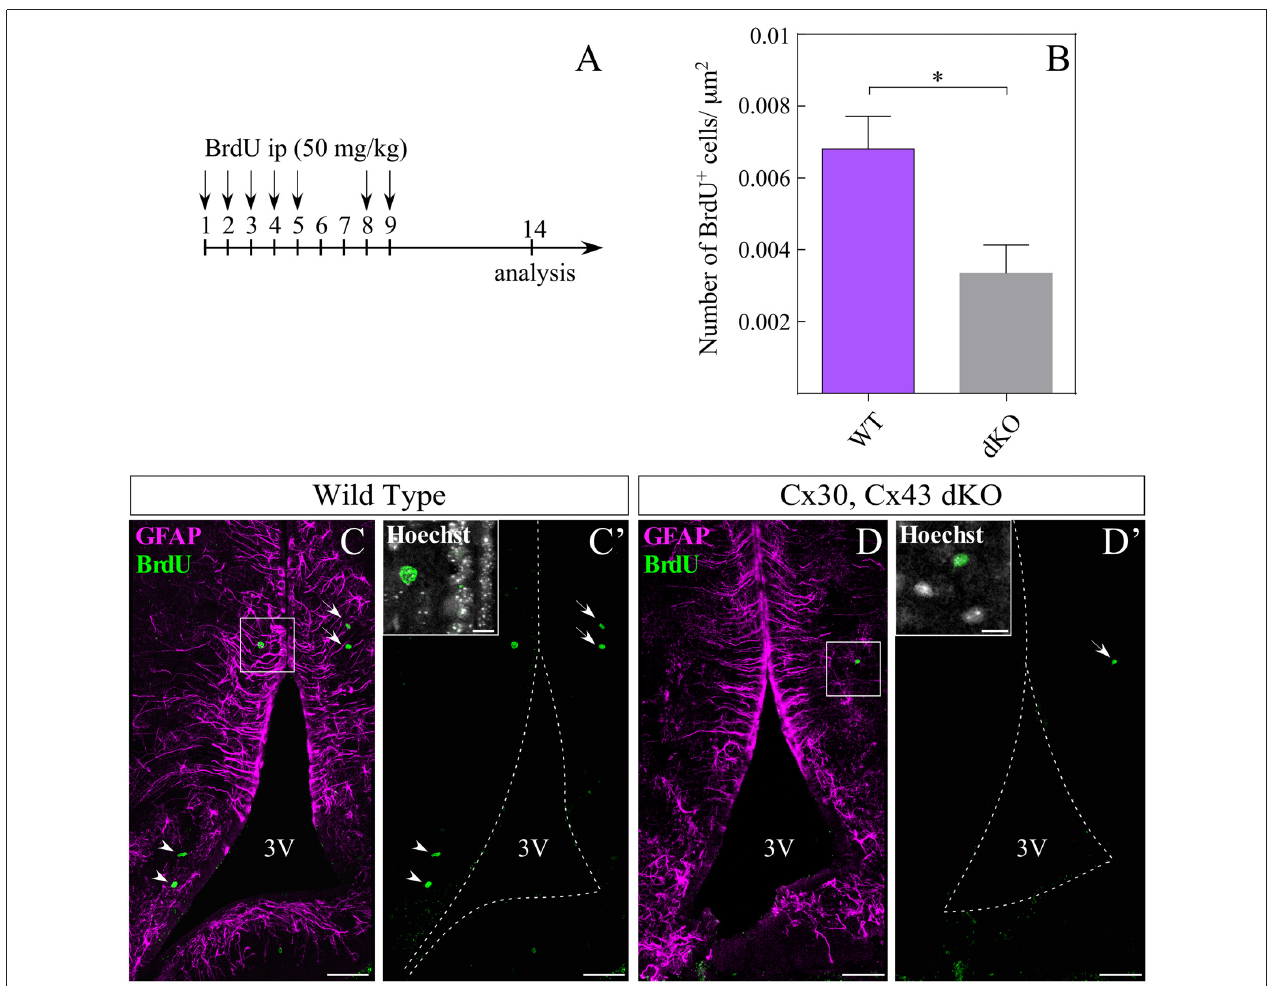
FIGURE 7 | Loss of gap junction coupling affects hypothalamic cell proliferation. Intraperitoneal injection of bromodeoxyuridine (BrdU) was performed as described in (A) . (B) Number of BrdU-positive cells in the parenchyma was quantified in three dKO (13 slices) and four wild type mice (23 slices) and the results were normalized to the area analyzed ( µ m 2 ), using the ROI manager of ImageJ software. Statistical analysis was performed using the non-parametric Mann Whitney one tail test, ∗ P < 0.05. Representative immunohistochemistry using anti-BrdU (green) and anti-GFAP (magenta) antibodies in frontal sections of WT (C,C (cid:48) ) and dKO (D,D (cid:48) ) animals. Boxes in (C (cid:48) ,D (cid:48) ) indicate co-localization of anti-BrdU with nuclei staining (Hoechst). Arrowheads indicate BrdU staining close to the 3V, while arrows indicate BrdU-positive cells distal to the 3V. 3V, third ventricle. Scale bar (C,C (cid:48) ,D,D (cid:48) ) : 50 µ m, Scale bar (Hoechst box): 10 µ